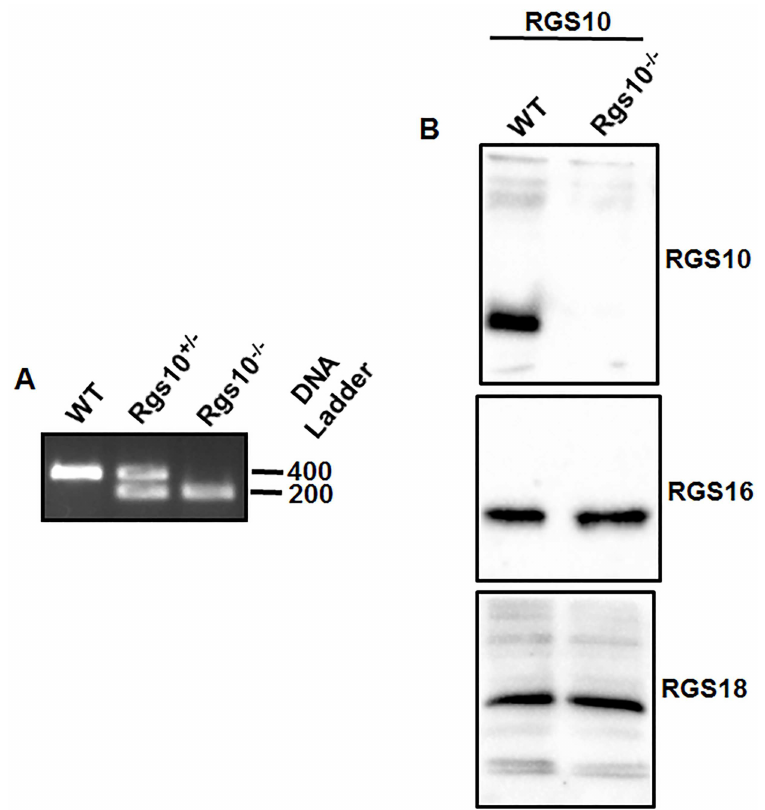
Fig 1. RGS10 deficiency does not affect platelet RGS protein levels. (A) DNA was isolated, and PCR was performed as describedin the “Methods” section. DNA was separated on a 1% agarose gel and visualized using a gel documentation system. (B) Platelet extracts (2 x 10 8 /ml) were preparedfrom wild type (WT) and the Rgs10 -/- mice. Proteins were probed using Western Blot.